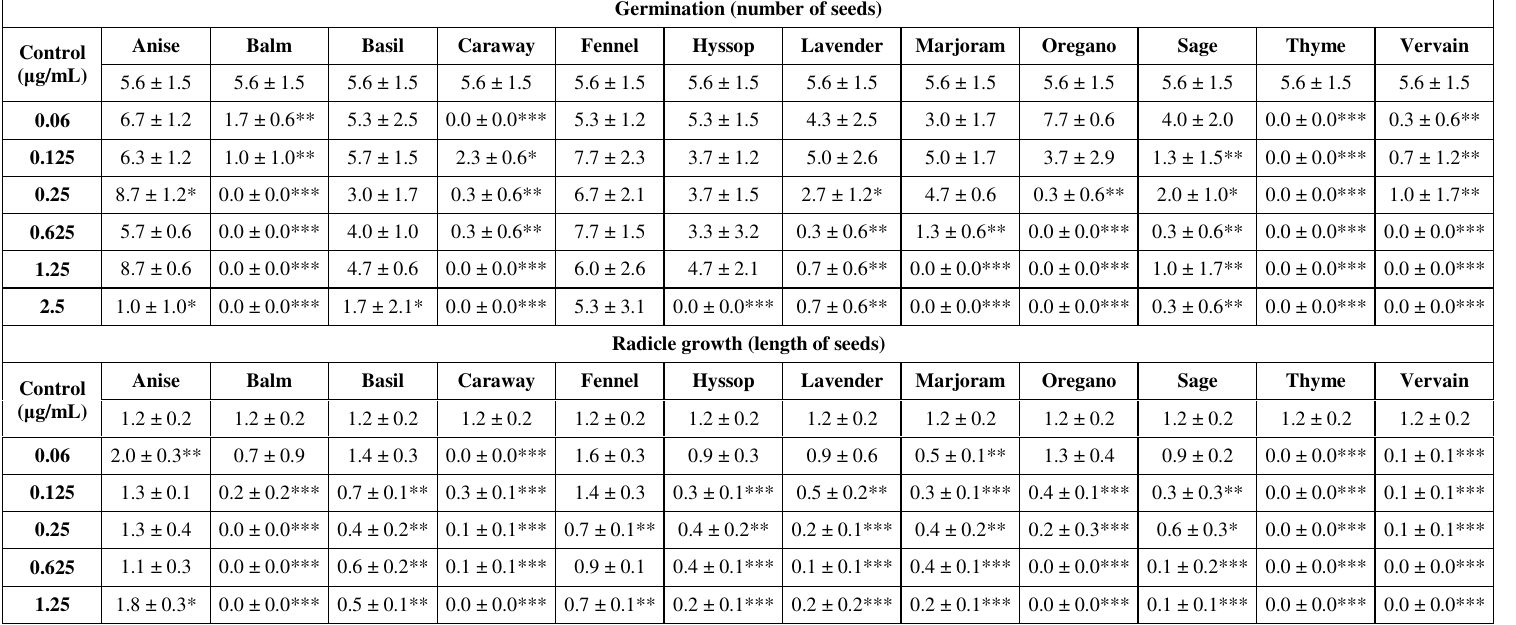
Table 5. Effects of different doses of essential oils on germination and radicle elongation of Lactuca sativa . The data are expressed as mean of three replicates ±